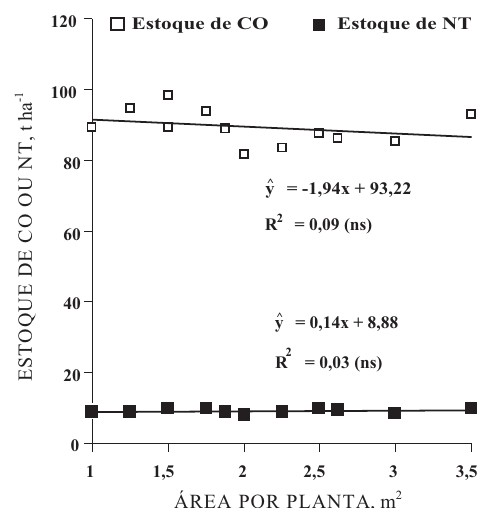
Figura 1. Relação entre a área ocupada por planta e o estoque de carbono orgânico (CO) e de nitrogênio total (NT) na camada de solo de 0– 40 cm. ns,